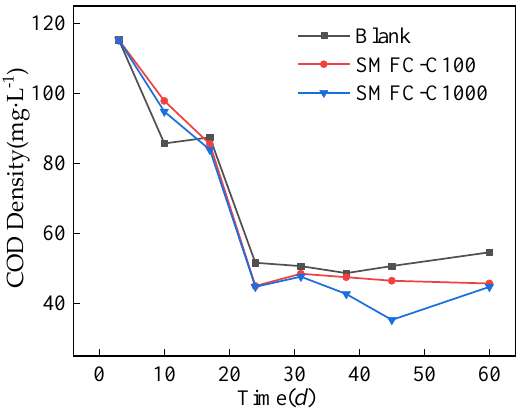
Figure 4. COD concentration curves.